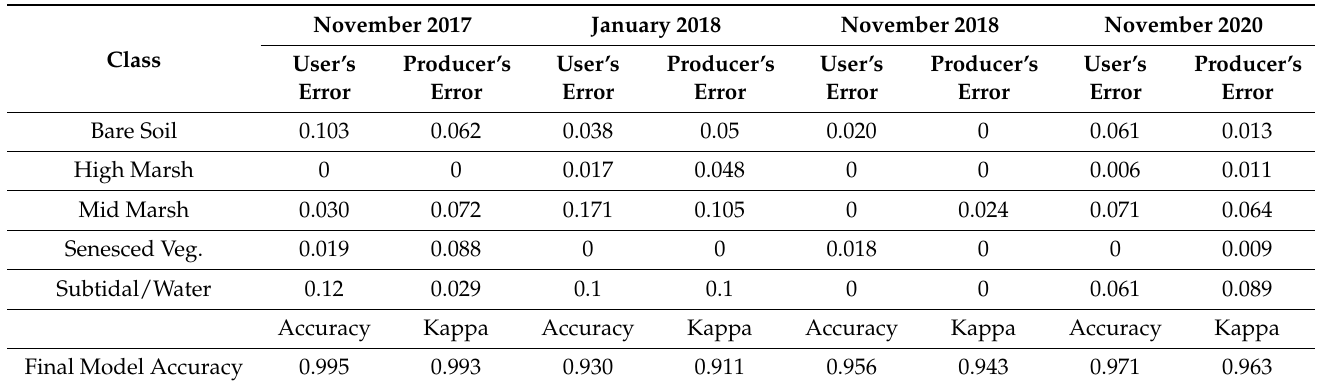
Table 4. Class error and final model accuracy across